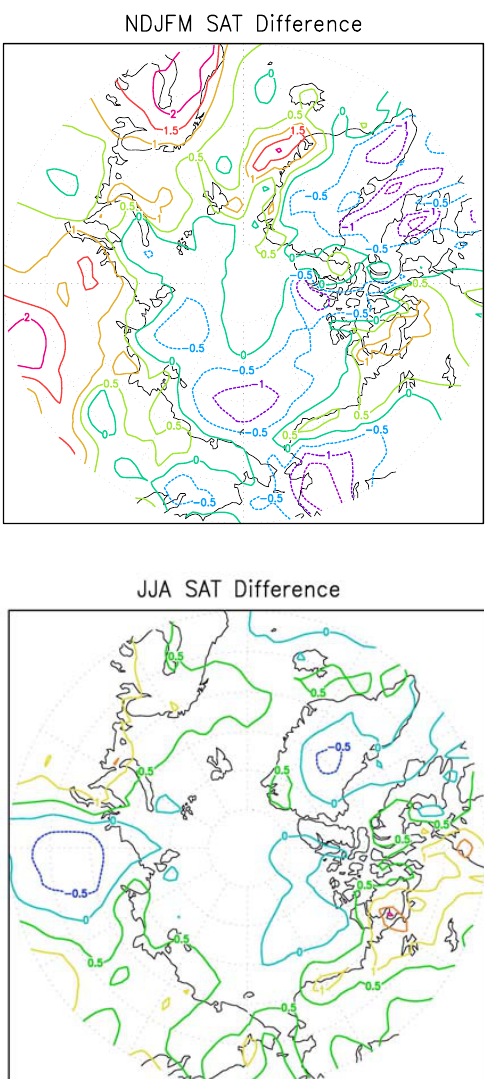
Fig. 8. Difference of surface air temperature between the periods 1975–1987 and 1988–2000. Winter months (November–March) are shown in the upper figure, and summer months (June–August) in lower figure.